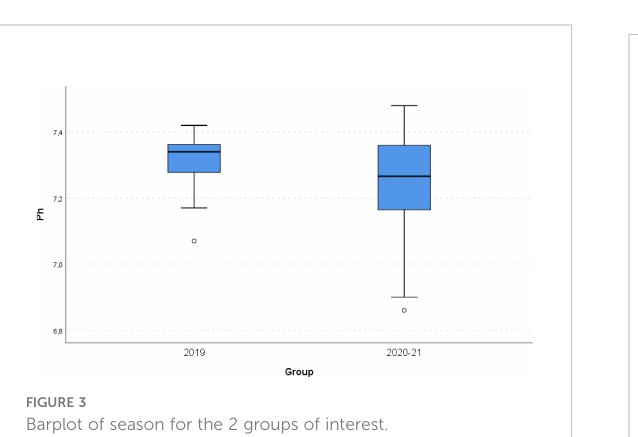
FIGURE 4 Barplot of season for the 3 groups of